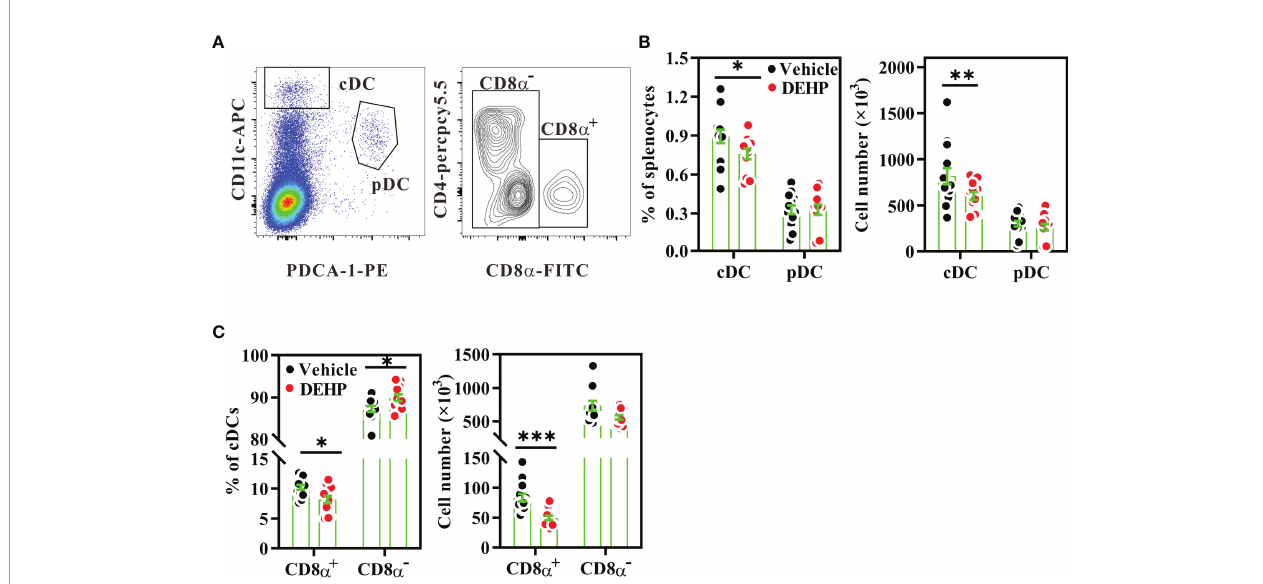
FIGURE 3 | Analysis of frequencies and numbers of splenic DC subsets. BALB/c mice were given oral DEHP, at a dosage of 37 m g/kg BW/day, or 0.33% ethanol in corn oil as vehicle, for 10 d. Splenocytes from the treated mice were assessed for DC subsets using multi-parametric fl ow cytometry. (A) Representative dot plots showing splenic cDCs (CD11c high PDCA-1 - ) or pDCs (CD11 low PDCA-1 + ) (left) and CD8 a + (CD4 - CD8 a + ) and CD8 a - (CD4 + CD8 a - and CD4 - CD8 a - ) DCs gated on cDCs (right) from a vehicle mouse. The percentages or numbers of cDCs, pDCs (B) , CD8 a + DCs and CD8 a - DCs (C) in spleens. n=14 mice per group from three independent experiments. Results are shown as mean ± SEM. *P < 0.05, **P < 0.01, and ***P < 0.001 vs. vehicle (as assessed using Mann – Whitney U